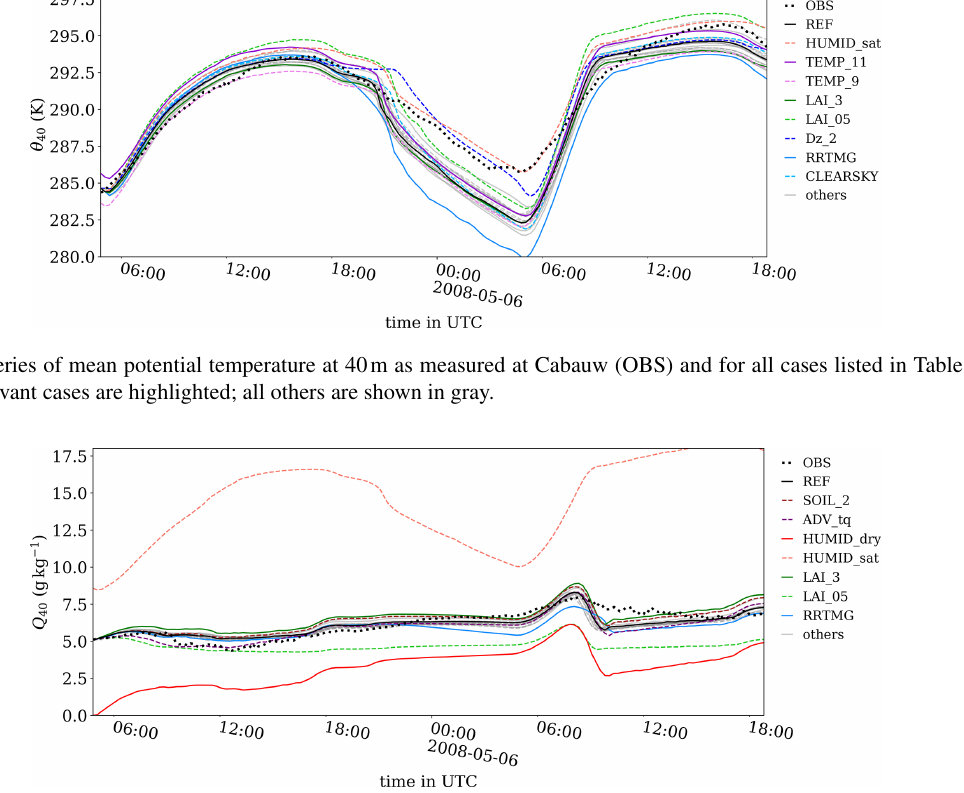
Figure 12. Time series of mean total water mixing ratio at 40m as measured at Cabauw (OBS) and for all cases listed in Table 5. Only case REF and some relevant cases are highlighted; all others are shown in